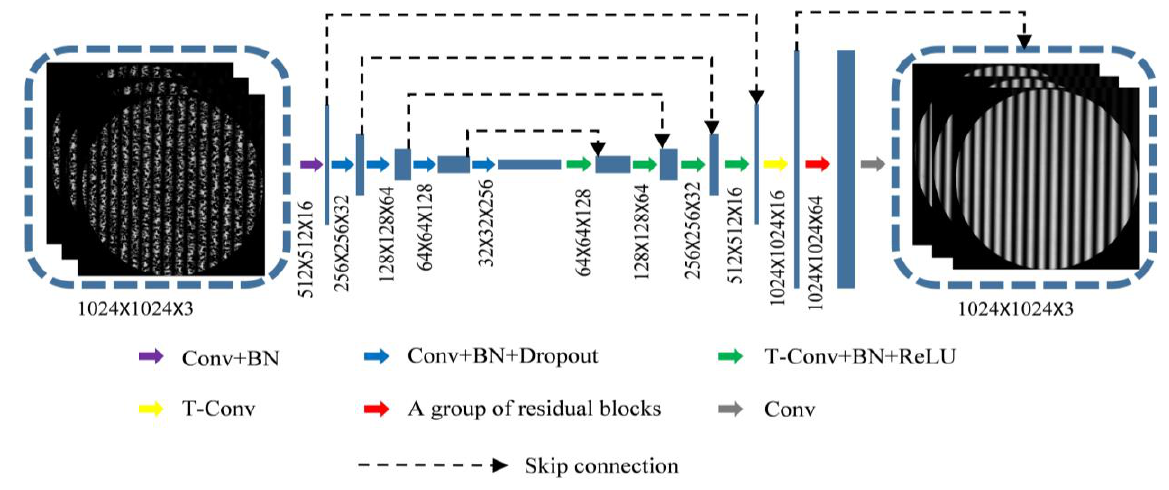
Figure 3. U-shaped CNN structure.